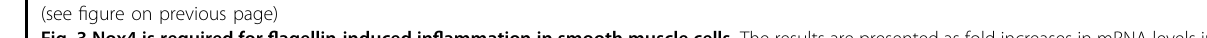
Fig. 3 Nox4 is required for fl agellin-induced in fl ammation in smooth muscle cells. The results are presented as fold increases in mRNA levels in fl agellin-stimulated cells compared with unstimulated cells (black circles: WT SMCs, white circles: Nox4 KO SMCs) ( a – g ). a Quanti fi cation of ICAM-1 mRNA expression in VSMCs ( N = 3, mean ± SD, compared with the Nox4 KO SMC group, * p < 0.05). b Quanti fi cation of MCP-1 mRNA expression. ( N = 3, mean ± SD). c Quanti fi cation of RANTES mRNA expression ( N = 3, mean ± SD, * p < 0.05). d Quanti fi cation of IL-1 β mRNA expression ( N = 3, mean ± SD). e Quanti fi cation of TNF- α mRNA expression ( N = 3, mean ± SD). f Quanti fi cation of IL-6 mRNA expression ( N = 3, mean ± SD, *** p < 0.001). g WT and Nox4 KO SMCs were stimulated with fl agellin (100 ng/mL) for 12 h. IL-6 protein secretion was analyzed by ELISA ( N = 3, mean ± SD, * p < 0.05, ** p < 0.01). h Effect of an NF-kB inhibitor (BAY11-7082) on IL-6 expression in WT